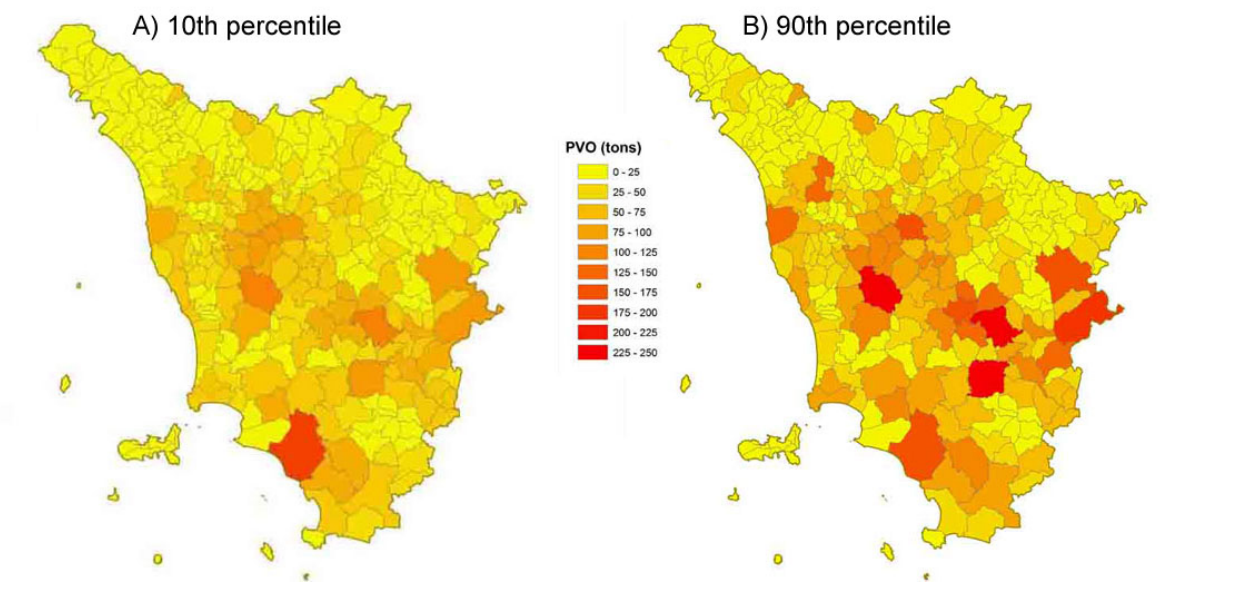
Fig. 2. Maps of 10th and 90th percentile of potential production of pure vegetable oil (PVO) in the reserved lands of